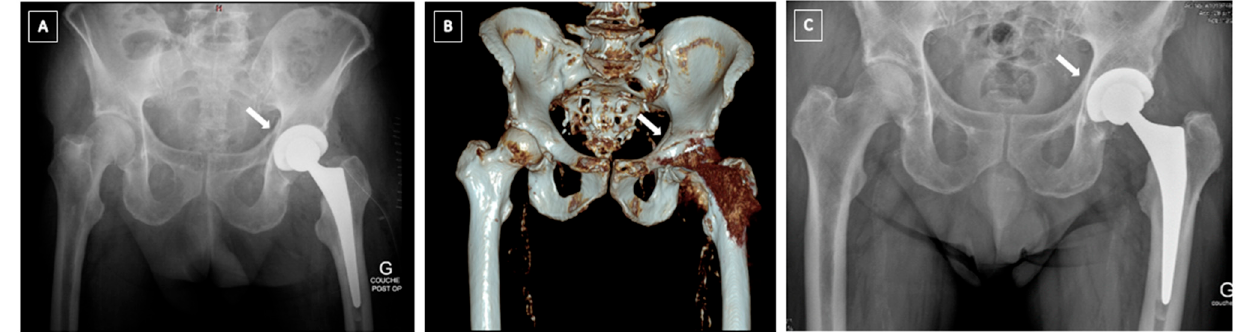
Figure 2. Intra-operative fracture of the left acetabulum recognized on immediate post-operative X-rays. It was treated non-operatively with 8 weeks of non-weight bearing with a favourable outcome. ( A ) postoperative CT scan showing the non-displaced fracture of the anterior column according to Judet and Letournel’s classification; ( B ) Immediate postoperative X-Ray; ( C ) X-Ray at 1 year follow-up.